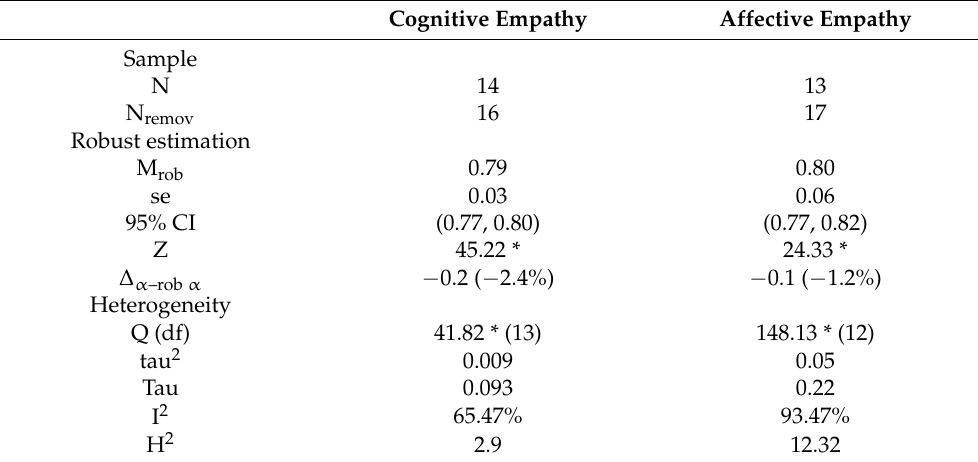
Table 5. Analysis and robust estimation of the meta-analytical Cronbach’s α